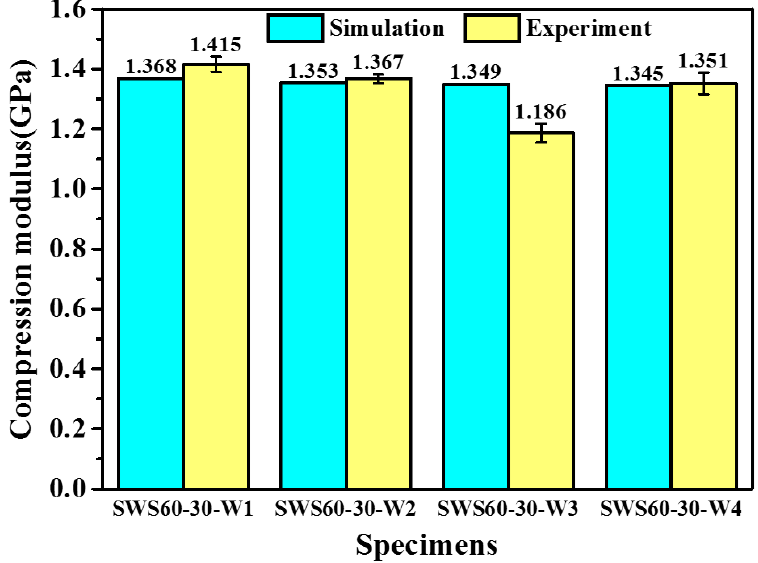
Figure 5. The simulation and experimental results of compression modulus for specimens reinforced with different WKSFs.